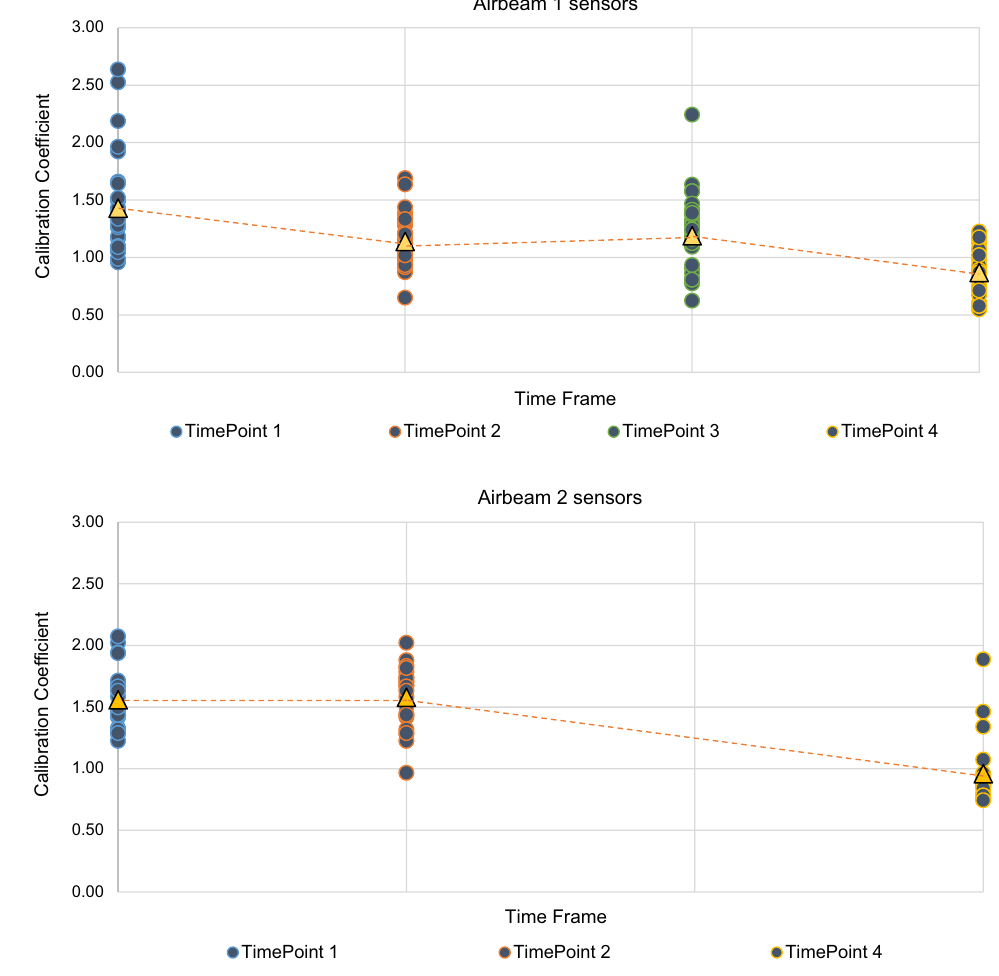
Figure 1. Between-and-within variability for calibration coefficient measurements over a 2-year timeframe: low-cost Airbeam 1 and Airbeam 2 particle